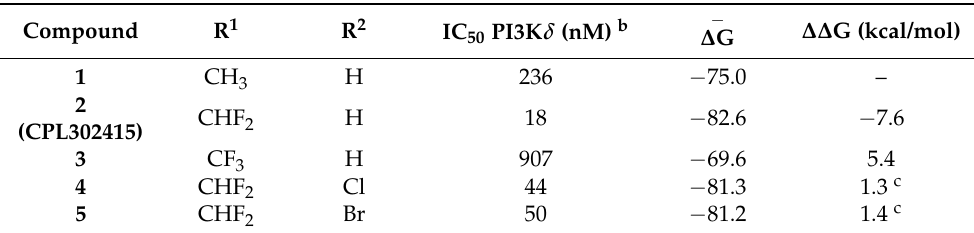
a The interaction energy gain averaged by three ligand–receptor complexes of each derivative selected from the MD simulations. b IC 50 values were determined as the mean from two independent experiments. c ∆∆ G values calculated as a difference between a given derivative and its nonhalogenated (difluoromethyl)-1 H -benzimidazole